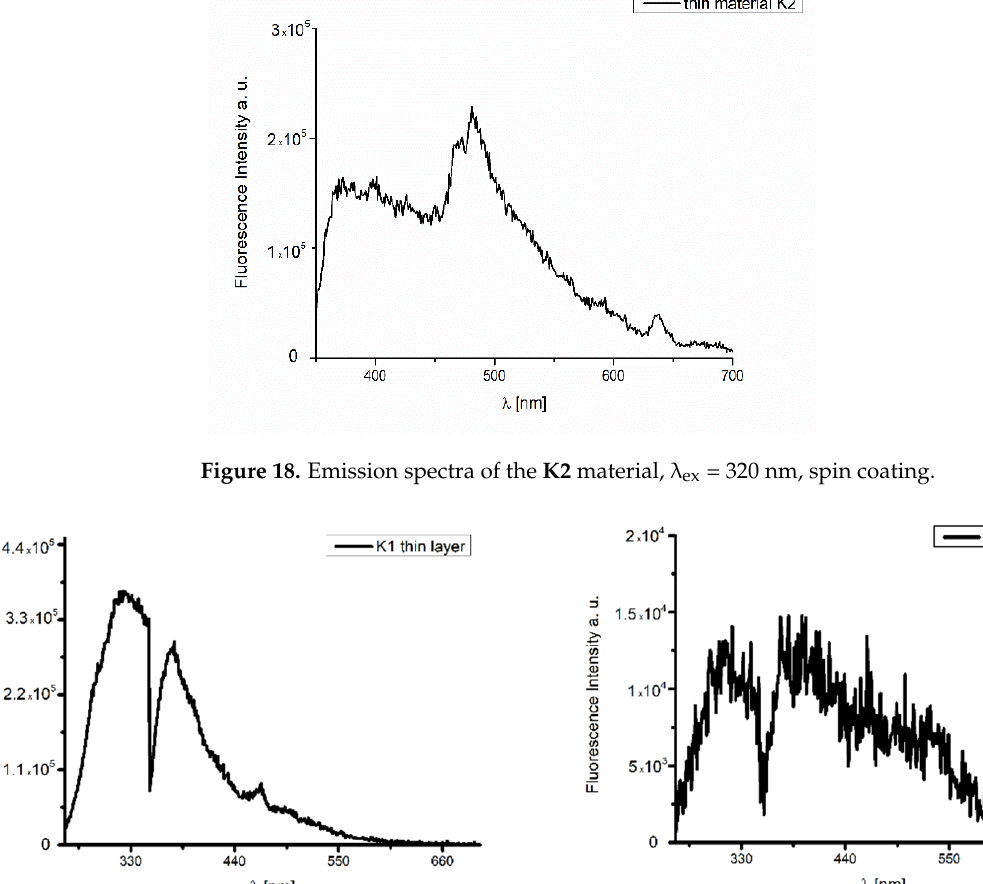
Figure 19. Emission spectra of K1 /Si and K2 /Si thermal deposition.